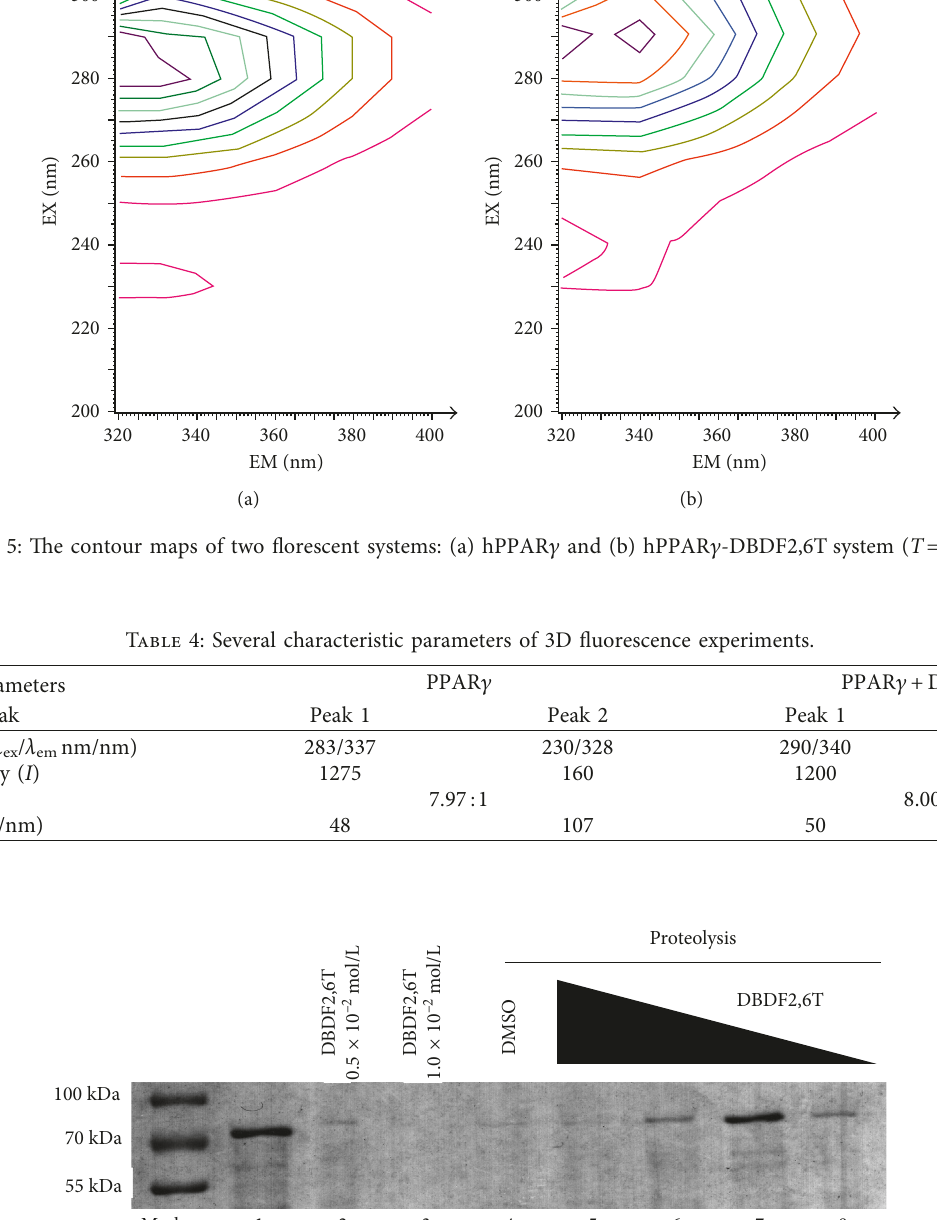
5 mol/L), respectively, and with 10 × −